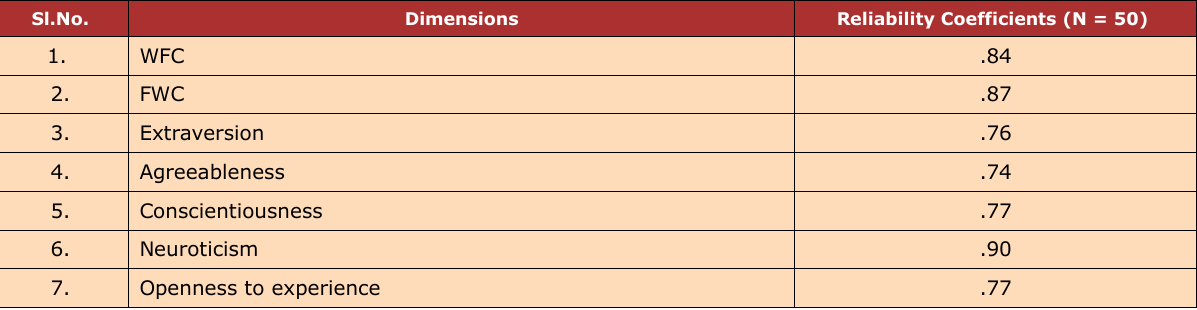
Table 1. Reliability coefficients using Cronbach